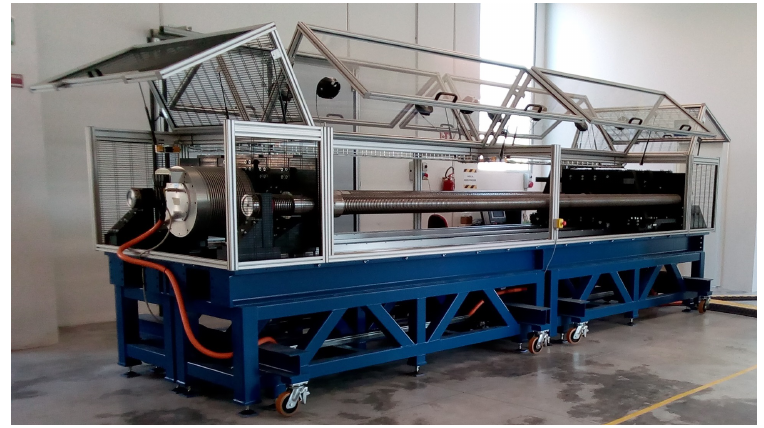
Figure 4. EMU installed on the HIL test rig at VGA facilities.